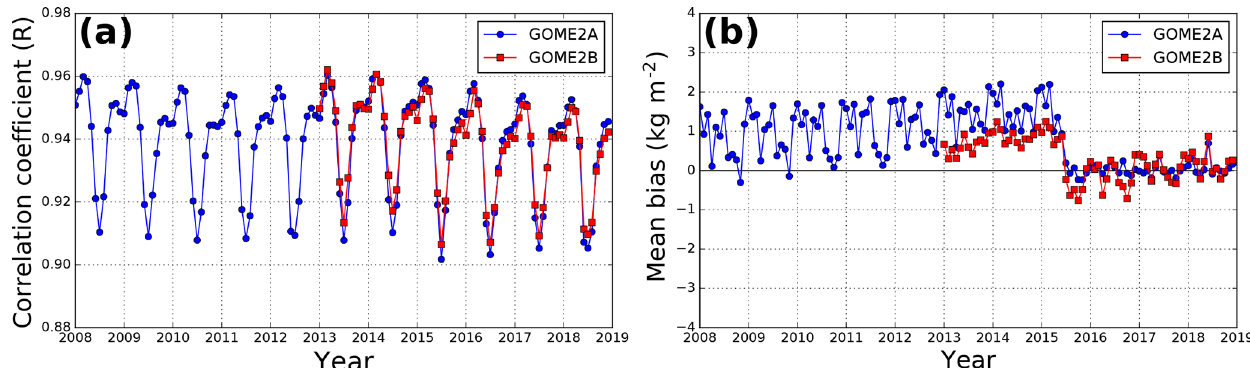
Figure 10. Time series of a Pearson correlation coefficient between water vapor columns from the blue band retrieval and operational algorithm is shown in (a) . Panel (b) shows the mean bias between the two data sets. Both GOME-2A and GOME-2B data are shown. Individual measurements are used in the calculation of correlation coefficient and mean bias.